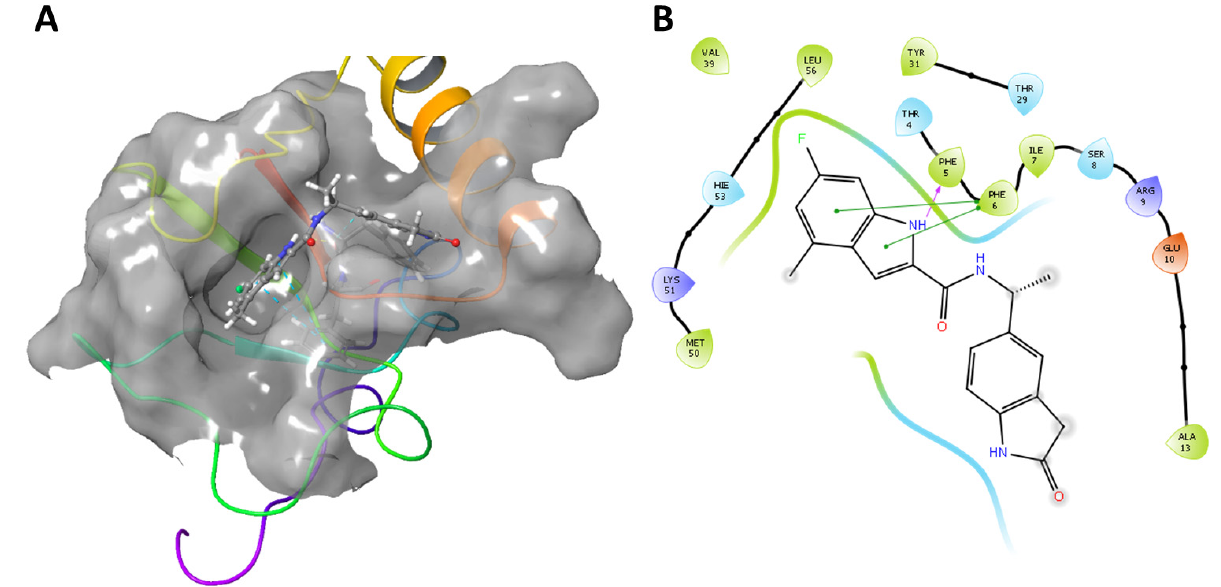
Figure 10. 3D ( A ) and schematic 2D ( B ) representations of the interactions between selected top-scoring compound CPE2 and Mult1_lr model. ( A ) Yellow: hydrogen bonds, blue: Pi-stacking. ( B ) Purple: hydrogen bonds, green: Pi-stacking.